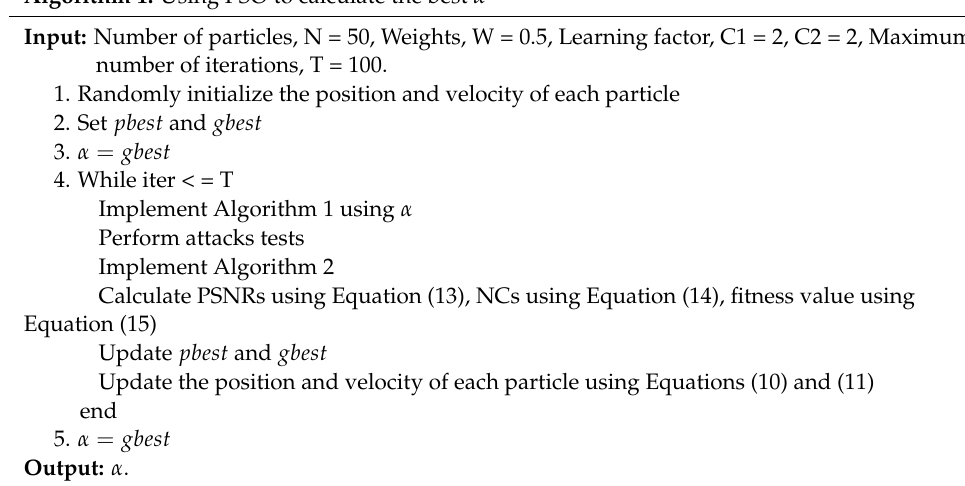
Algorithm 1: Using PSO to calculate the best